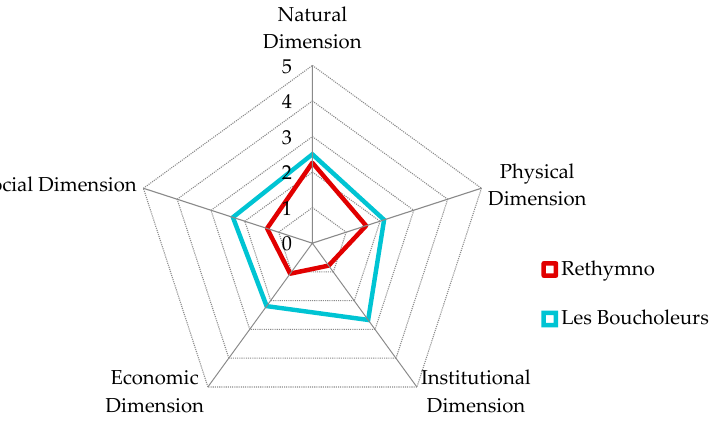
Figure 20. Comparing flood resilience of Rethymno and Les Boucholeurs case study.